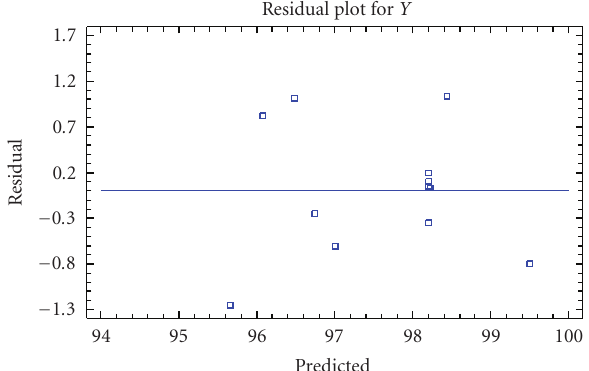
Figure 2: Normal probability plot for the methyl esters yield.